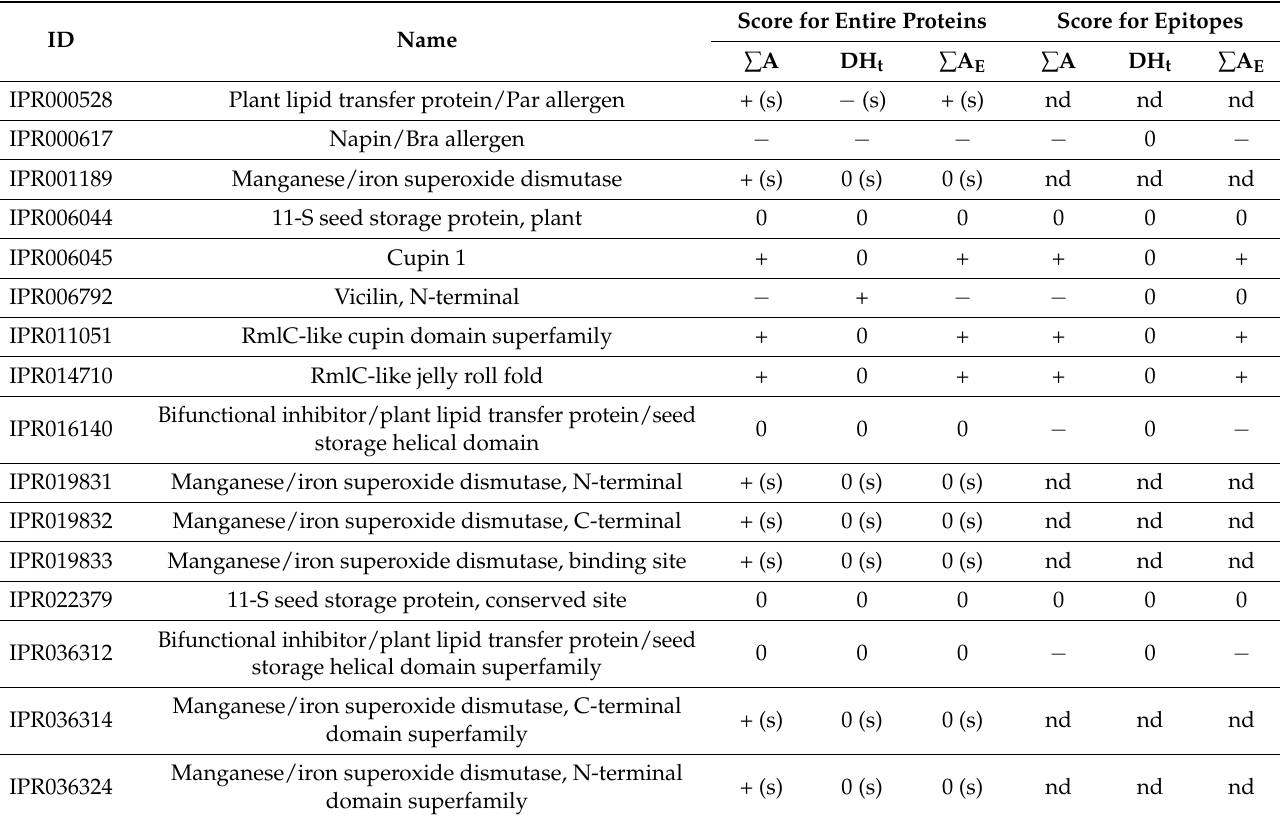
Figure 9. Cupin domain proteins associated with relatively high ∑ A scores. Ana o 1.0101 or ( a ) and Ana o 2.0101 ( b ) ribbon models indicating the relative placement of segments within the two allergens having high ∑ A scores. Loop sections are colored red, cupin domains yellow, and segments with high ∑ A scores in green. Table 3. Summary of domains present in allergenic proteins.